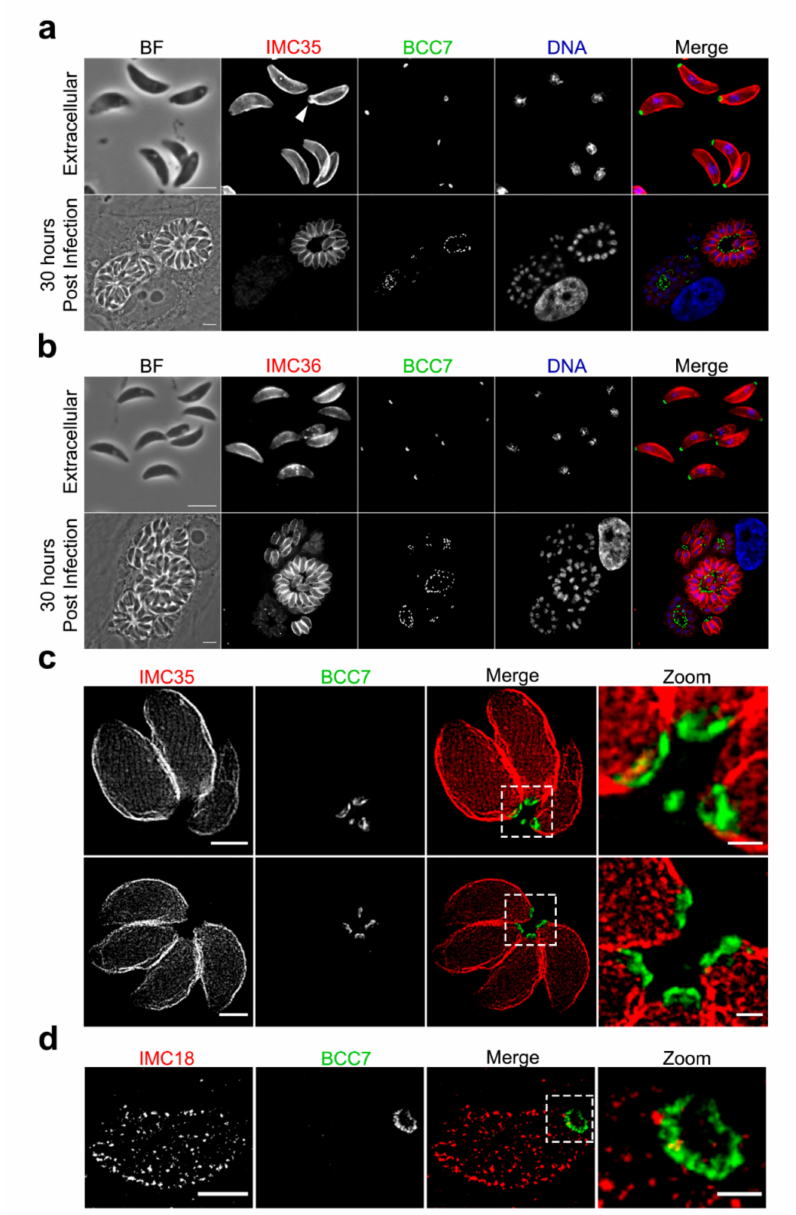
Figure 5. Cell-cycle-dependent expression of IMC35 and IMC36. Parasites expressing endogenously fused BCC7-mEm (green) and IMC35-mC ( a ) or IMC36-mC ( b ) proteins (red) were fixed and stained with DAPI (blue) before images acquisition (ZEISS ApoTome.2 microscope). Different steps of the division process were observed as indicated. IMC35 showed a continuity with the BCC7 ring structure on extracellular parasites (white arrowhead). Scale bars: 5 µ m. ( c ) STED imaging of tachyzoites co-expressing BCC7-mEm and IMC35-mC and immunostained with anti-GFP and anti-mCherry antibodies respectively. Appropriate secondary antibodies conjugated to either Abberior STAR Orange (BCC7-mEm, green) or Abberior STAR Red (IMC35-mC, red) were used. Note the pattern alignment of IMC35 with the microtubule basket orientation and the spatial proximity between IMC35-mC and BCC7-mEm at the basal pole. ( d ) STED imaging of a rosette of intracellular parasites expressing endogenously fused BCC7-mEm and IMC36-mC using the same staining as in ( c ). Scale bars for ( c , d ): 2 µ m; for zoomed areas: 500